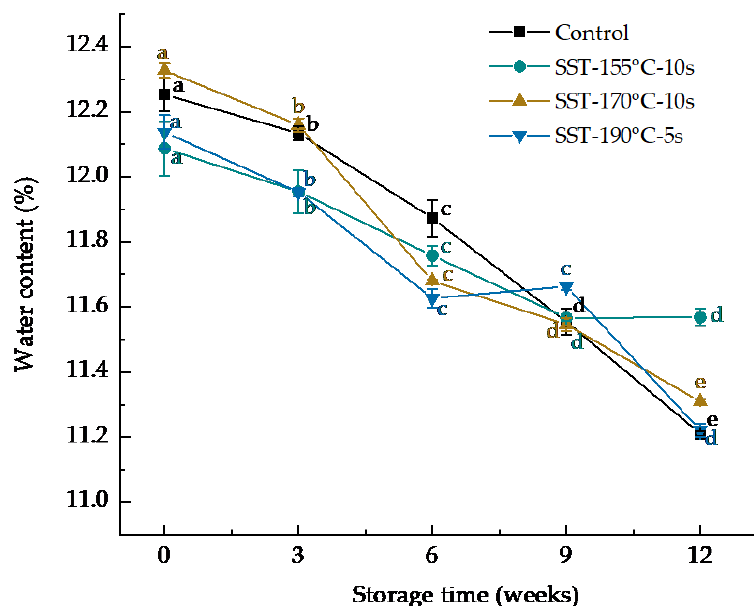
Figure 1. Effect of superheated steam treatment on moisture content of dried whole wheat noodles during storage. The lowercase letters indicate the significant difference of the same sample in different storage time at p < 0.05. SST: superheated steam treatment.